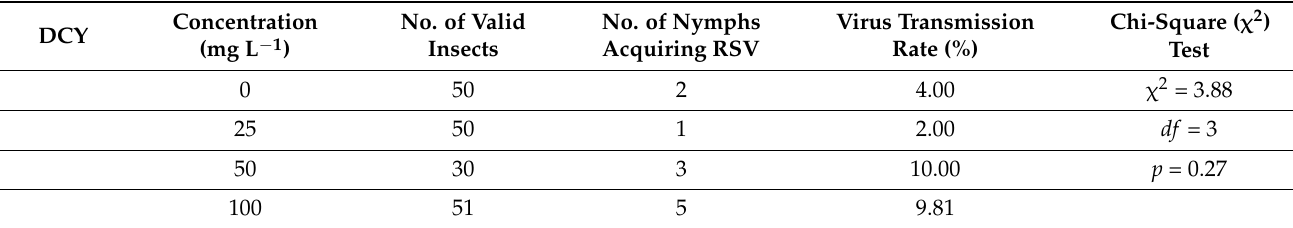
Table 2. RSV acquisition rate of SBPH fed on DCY-treated